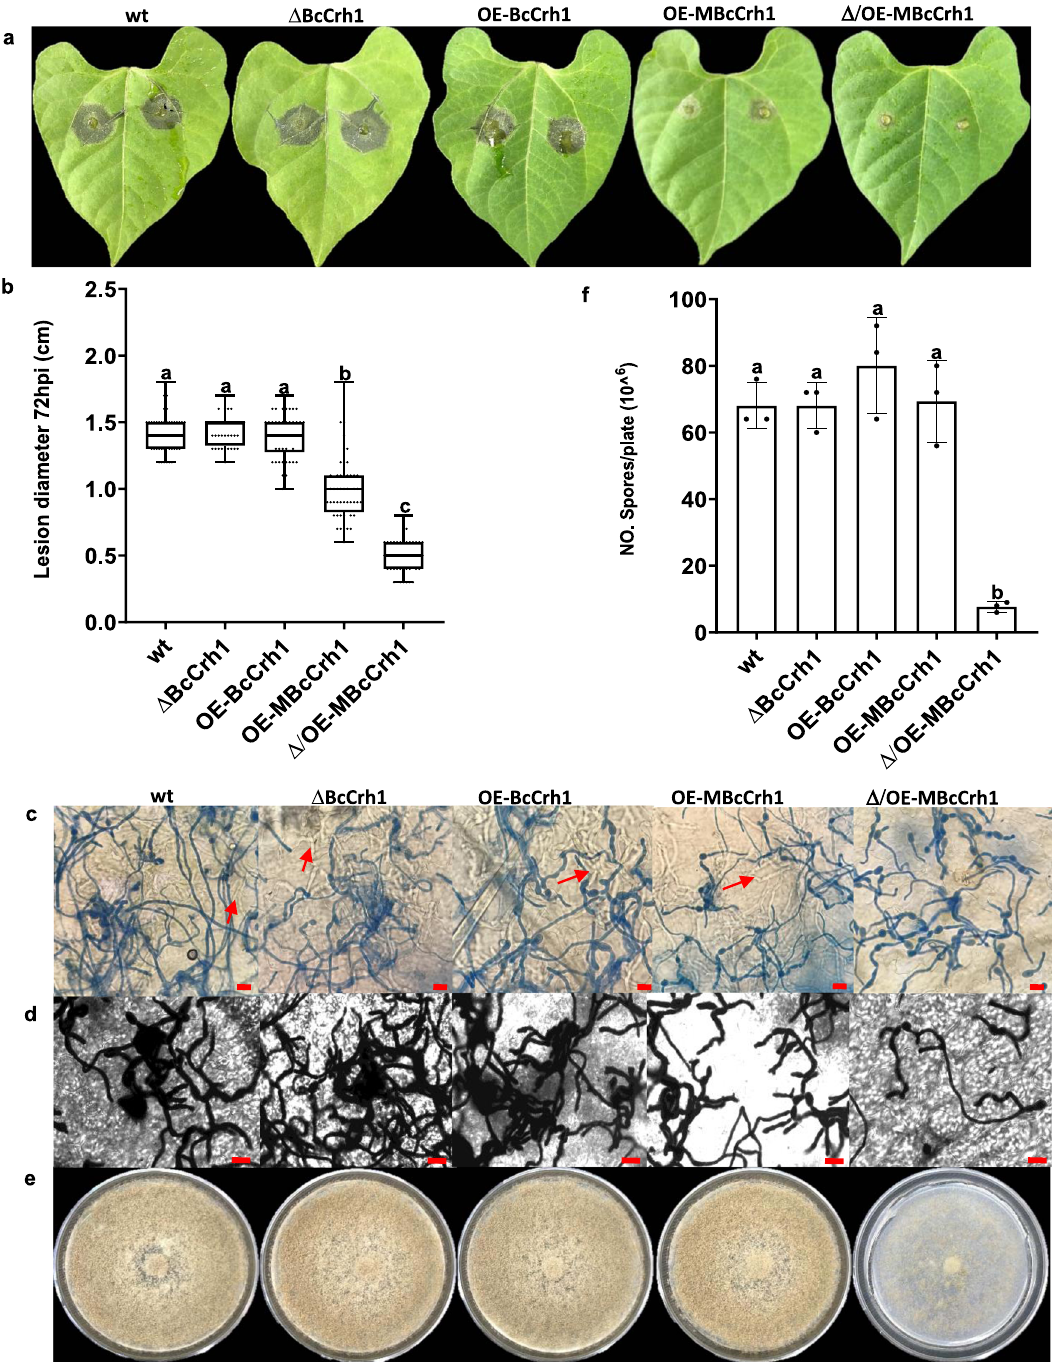
Fig. 6 Over expression of MBcCrh1 causes reduced pathogenicity and developmental defects. a – b Infection assay. Bean leaves were inoculated with spore suspensions of B. cinerea wild type (wt), bccrh1 deletion ( Δ BcCrh1), bccrh1 overexpression (OE-BcCrh1), and strains over-expressing the enzyme inactive (MBcCrh1) protein in wild type (OE-MBcCrh1) or bccrh1 deletion ( Δ /OE-MBcCrh1) genetic background. Symptoms were photographed and the lesion diameter was recorded 72 hpi. Box limits show the 25th and 75th percentiles. The center lines of boxplots indicate the medians values; whiskers extend to minimum and maximum values from the 25th and 75th percentiles; all data are indicated as black dots. At least 40 sample points from three independent biological replicates were used for statistical analysis. c – d Lactophenol cotton blue and lactophenol trypan blue staining of infected leaves. Leaf tissue was harvested at the designated time points and stained with lactophenol cotton blue, which stains only the exposed hyphae ( c ), and with lactophenol trypan blue, which stains both exposed and intracellular (red arrows) hyphae ( d ). Bar = 20 μ m. Note the near absence of intracellular hyphae in the Δ /OE-MBcCrh1 mutant, which indicates penetration defects. All the experiments were repeated three times with similar results. e – f Mycelium and spore production. Fungi were cultured on solid GB5-Glucose medium and grown at 20 °C with continuous light. Pictures were taken ( e ) and spores counted after eight days of incubation. Data represent mean ± SD from three independent biological replicates. Different letters in ( b ) and ( f ) indicate statistical differences at P ≤ 0.01 according to one-way ANOVA.